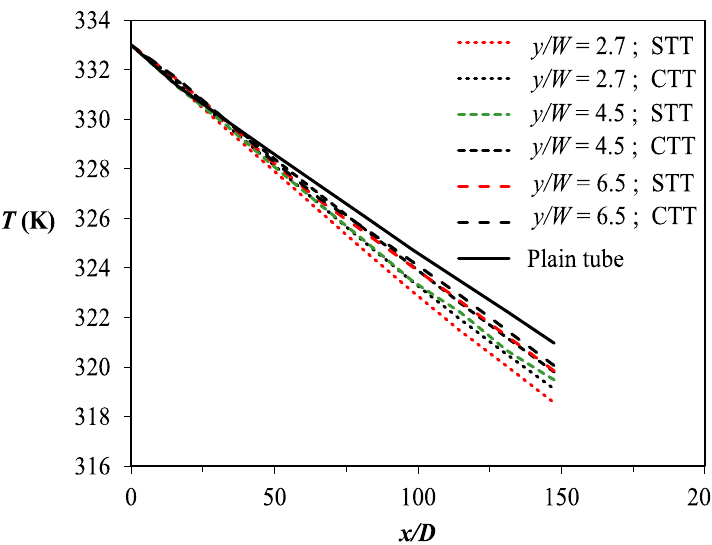
Figure 6. Streamline in cross sections at Re = 14,100.